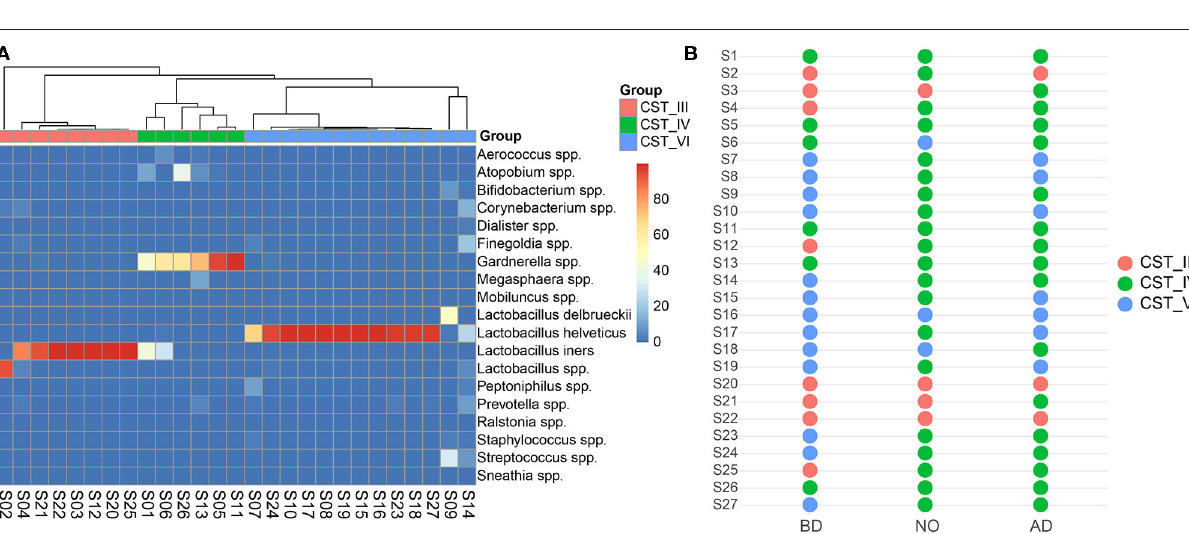
FIGURE 5 | Vaginal community state types presented throughout before and after delivery. (A) Hierarchical clustering analysis using McQuitty linkage of microbial species abundance showed that these subjects were clustered into three major groups. (B) The switch of community state types among the three